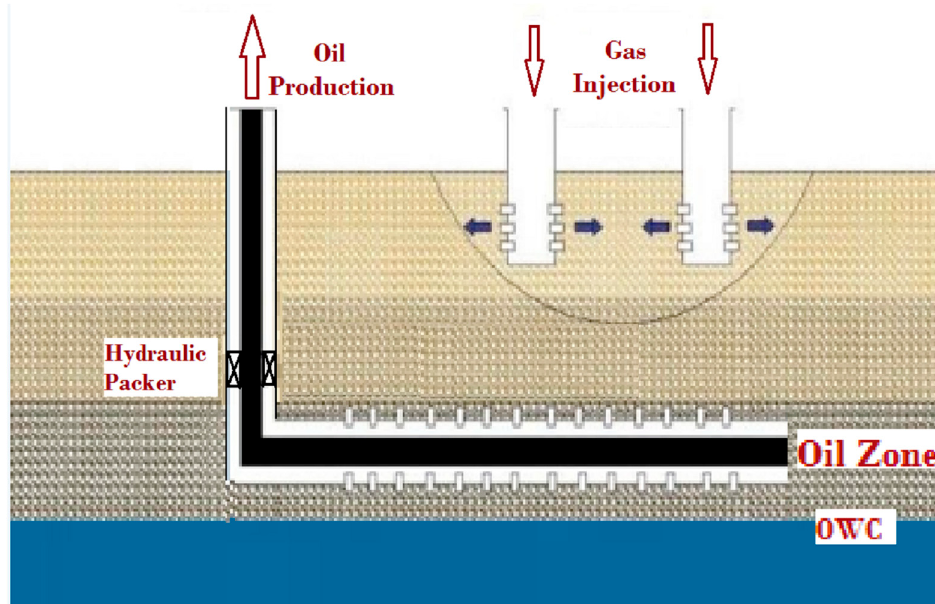
Figure 1. Schematic illustration of the GAGD